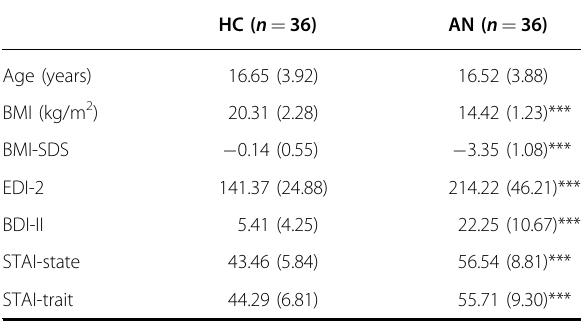
Table 1 Basic demographic and clinical